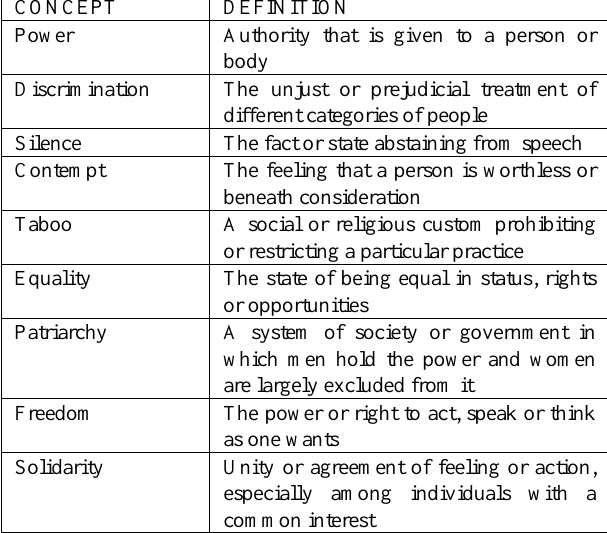
Figure 8. Pose mismatch in iPi MoCap Studio